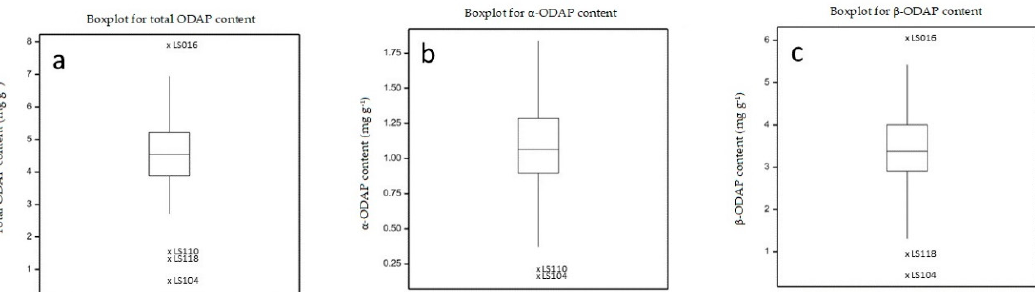
Figure 5. Frequency distribution of ( a ) total ODAP ( α and β ), ( b ) α -ODAP, and ( c ) β -ODAP contents, expressed as mg g − 1 sample in a collection of 107 grass pea plus two red pea accessions. Total ODAP content of the low ODAP grass pea accession (LS 104) and of the two red pea accessions (LS 110 and LS 118) are indicated.